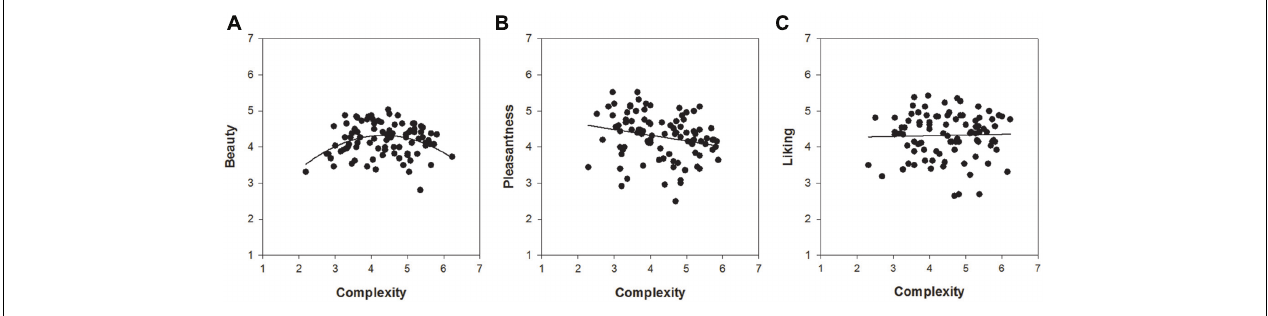
FIGURE 5 | The relationships between complexity and the three measures of hedonic tone for 19th-century piano solo music: (A) beauty, (B) pleasantness, and (C) liking.